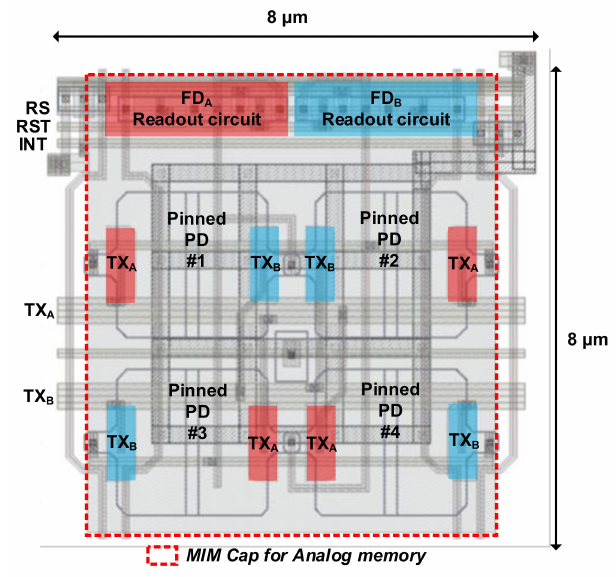
Figure 8. Pixel layout with the over-pixel analog memory